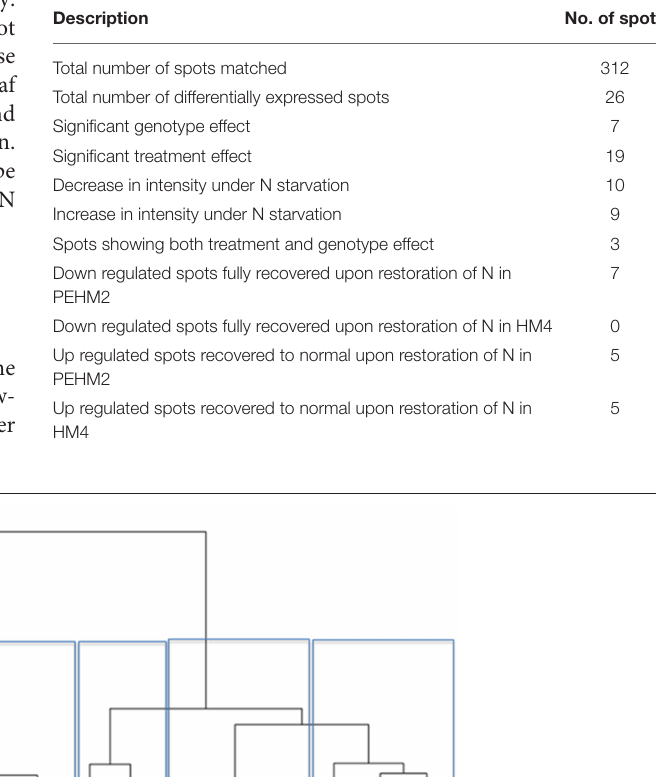
Frontiers in Plant Science |